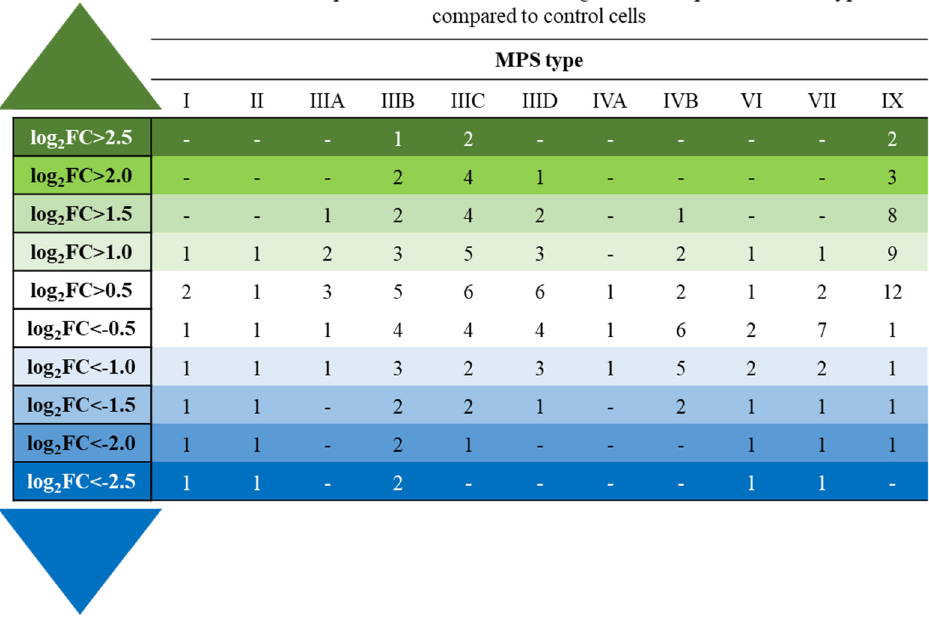
Figure 2. Number of transcripts included in the ‘lncRNA transcription’ term (GO:0140742) in the QuickGO database with altered expression depending on the level of fold-change (log2FC) in different types of MPS relative to control cells (HDFa). Table 3. Genes included in the ‘lncRNA transcription’ term (GO:0140742) with log 2 FC > 2.5 in specific MPS types relative to control cells (HDFa). Upward- and downward-pointing arrows indicate up- and down-regulation, respectively, while minus symbols indicate lower levels of changes. For MEG3 , three transcripts were identified, which were marked as t.1, t.2, and t.3. Transcript